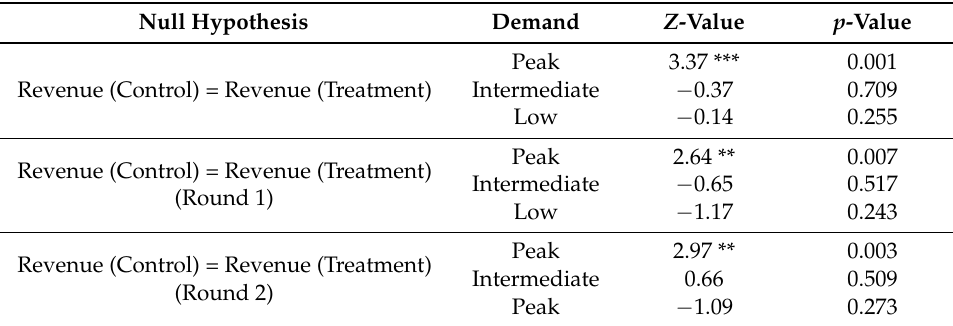
Table 3. Wilcoxon tests of treatment effects.